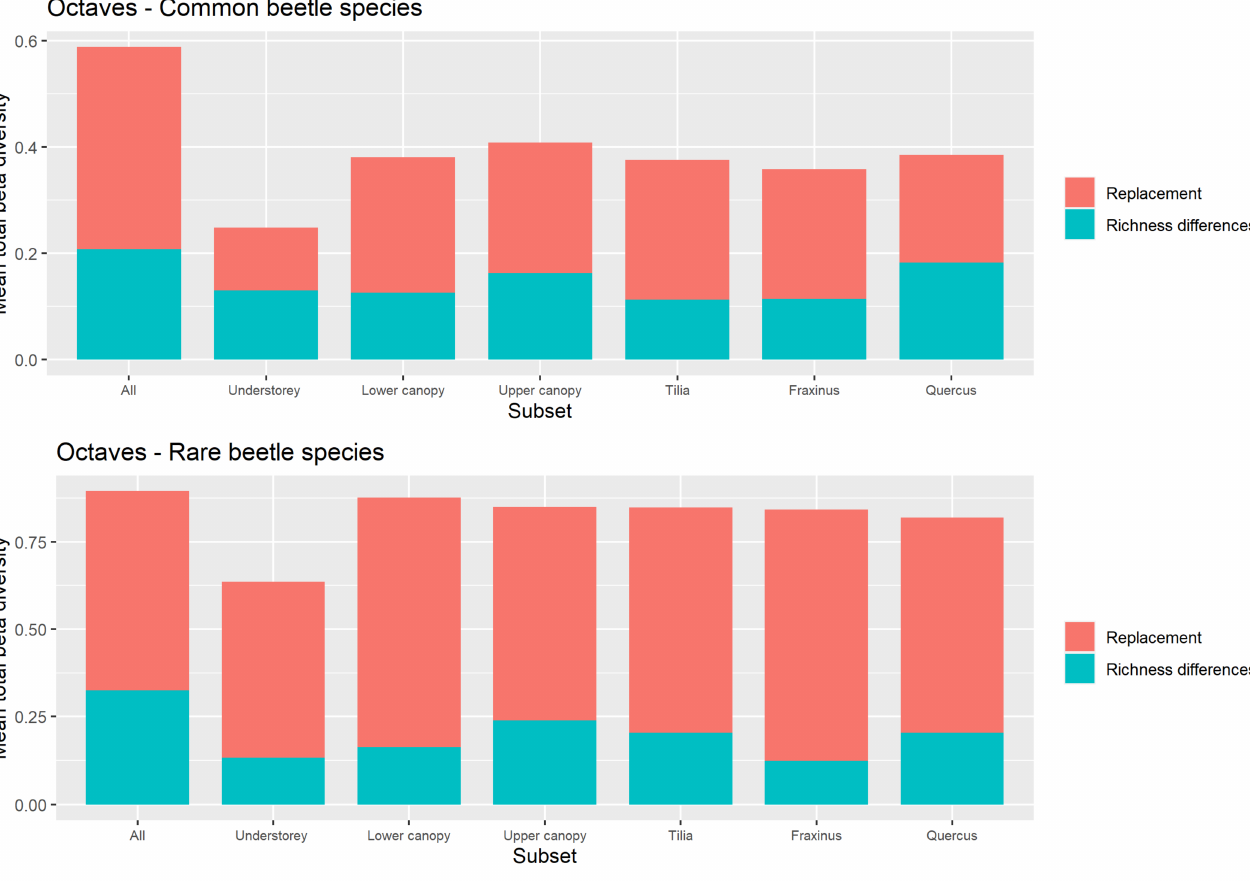
Figure A8. The contribution of replacement and richness differences to the total beta diversity for all studied strata and tree species, rarity classification according to the